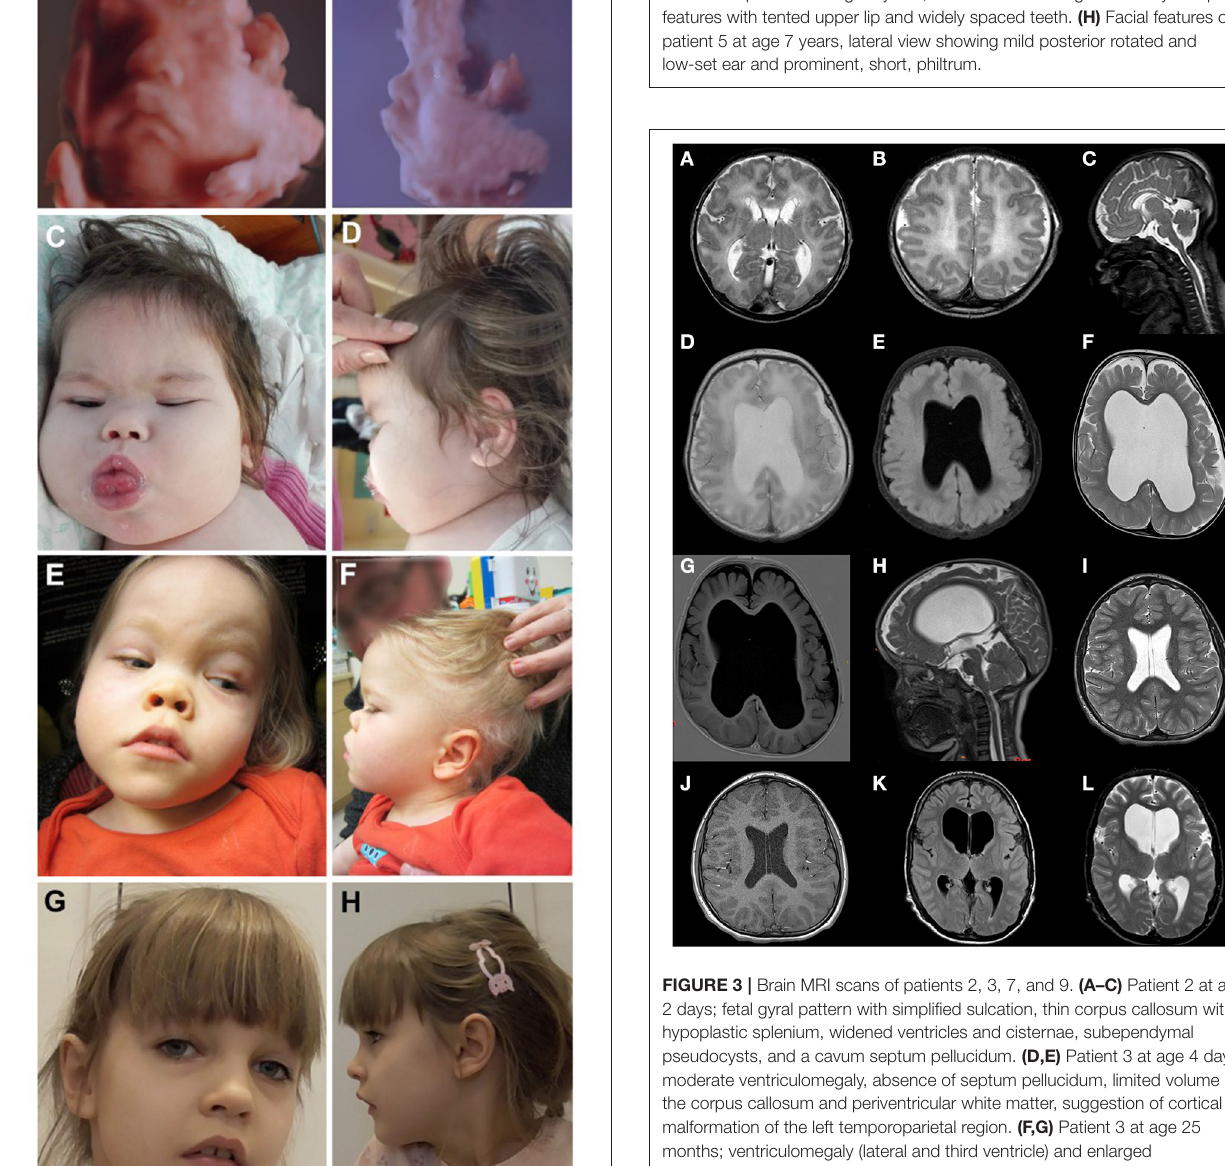
FIGURE 2 | features of patient 1 at age 3 years, lateral view showing deep-set eyes, upturned nasal tip, and low-set and posteriorly rotated ears. (G) Facial features of patient 5 at age 7 years, frontal view showing minimal dysmorphic features with tented upper lip and widely spaced teeth. (H) Facial features of